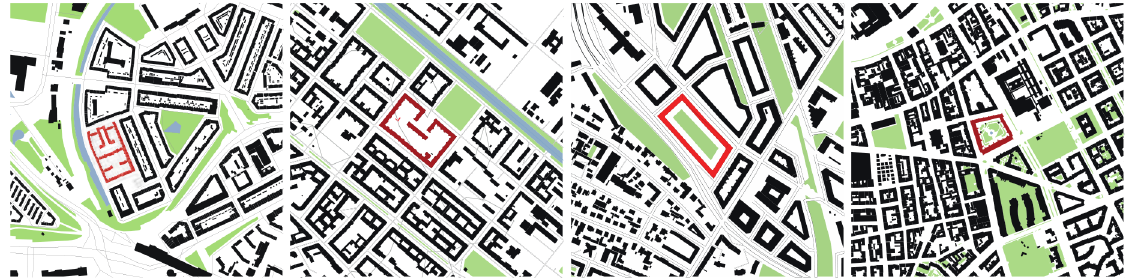
Figure 4. Drawings of the Elemente der Stadtarchitektur course at Potsdam School of Architecture, winter semester, 2018–2019. From left to right: Michiel Brinkman, Justus van Effen Block in Spangen , Rotterdam, 1919–1921; Paul Mebes,